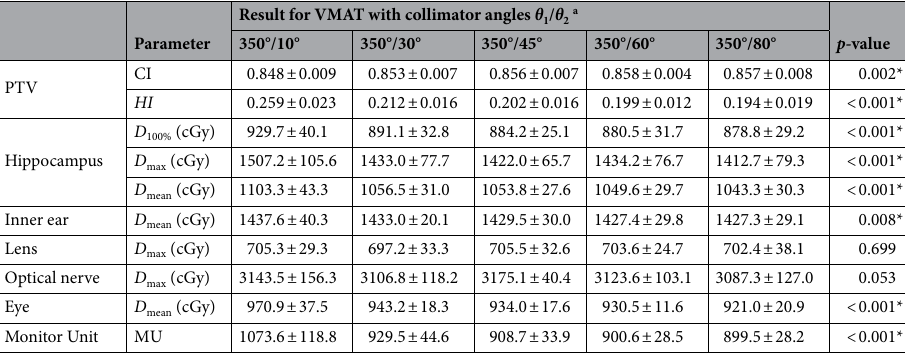
Table 2. Dosimetric parameters and MUs of VMAT plans with intersection angle of two collimators (Δ θ ) changing from 20° to 90°, along with their Friedman test results. a θ 1 and θ 2 indicate the collimator angles of arc 1 and arc 2, respectively. *Statistically significant ( p <